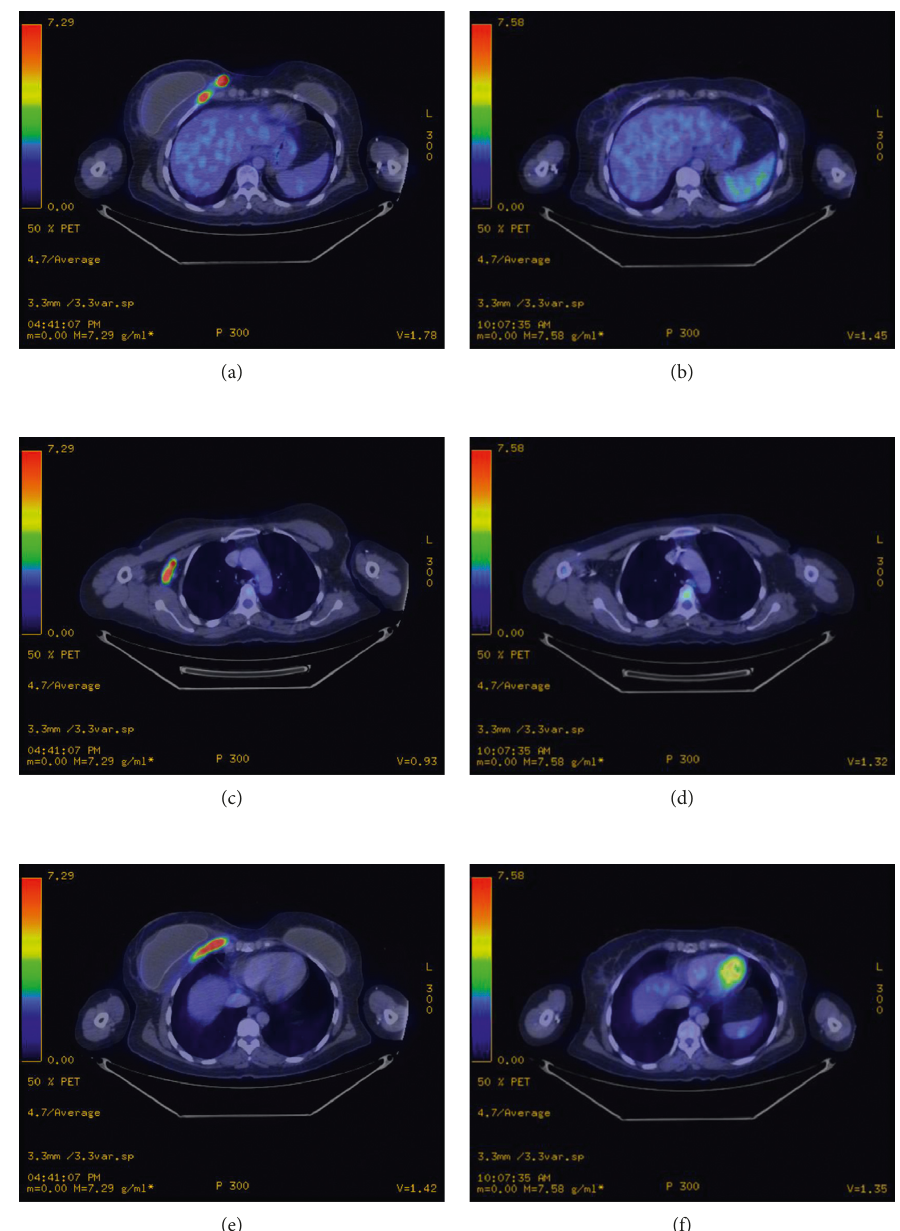
Figure 2: Pretreatment PET/CT staging scan showing right medial breast involvement (a) and restaging PET/CT after surgery and chemotherapy showing complete resolution of disease in the breast (b), pretreatment PET/CT showing right lymph node involvement (c) and posttreatment decrease in size of the nodes (d), and pretreatment right chest wall involvement (e) and posttreatment resolution of disease in chest wall